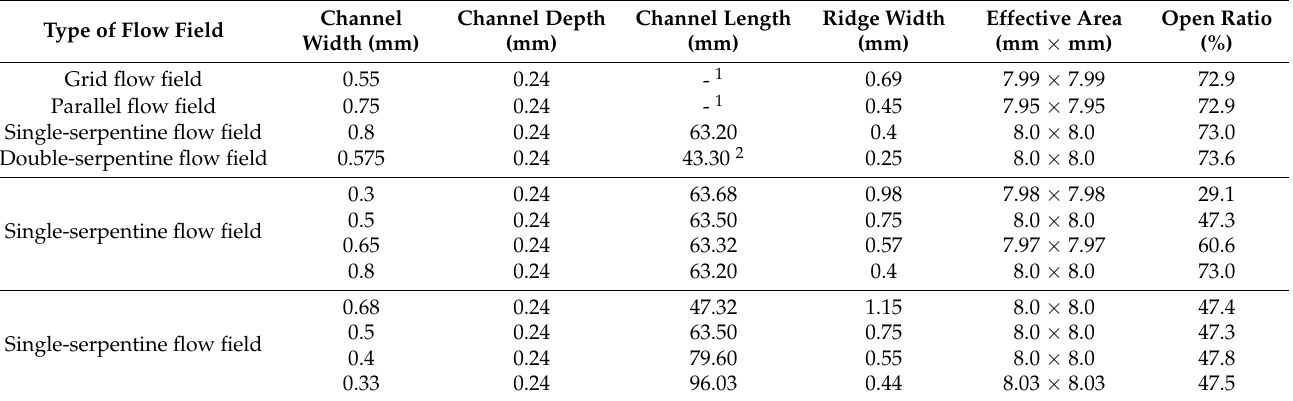
Table 5. Summary of the experimental anode flow field